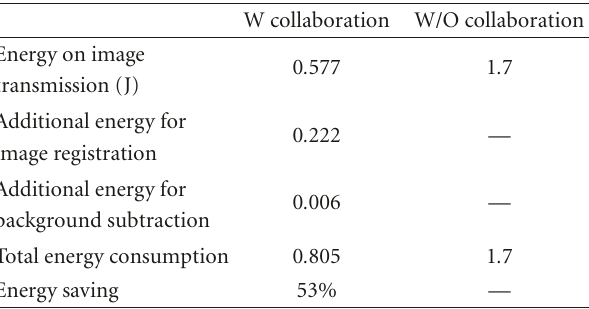
Table 1: Energy consumption comparison with and without the proposed collaborative image transmission